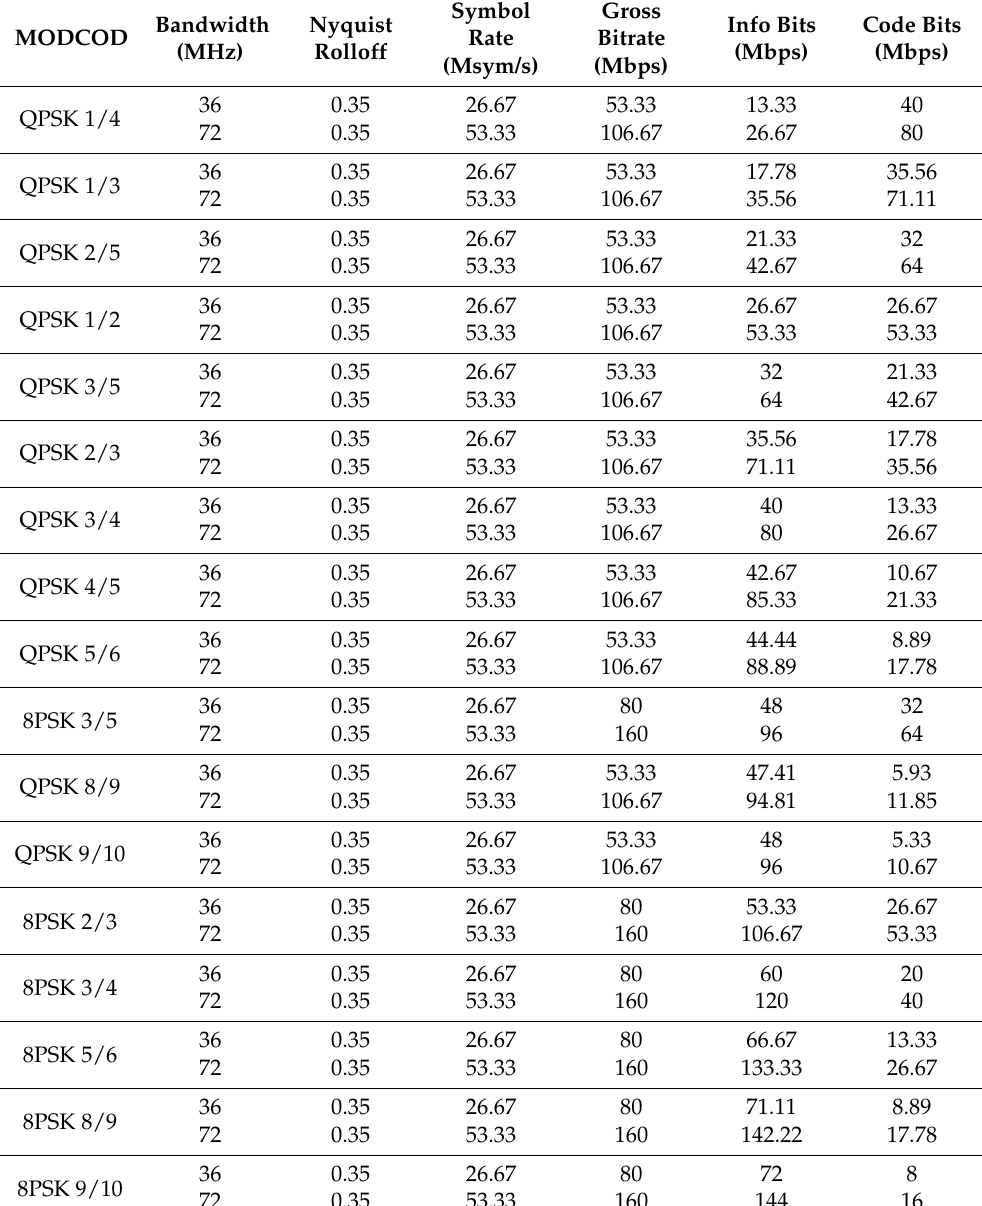
Table 5. Theoretical performance QPSK and 8PSK MODCODs in